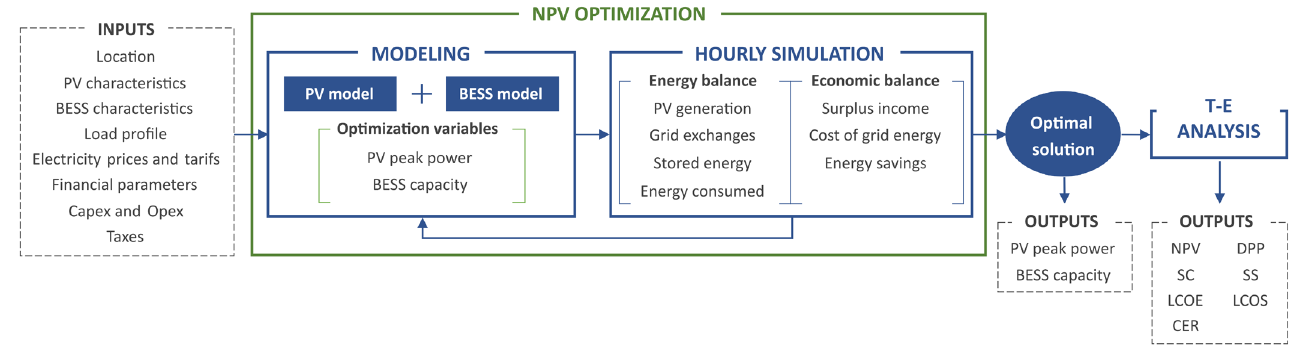
Figure 1. Optimization process implemented in the developed tool to design, simulate and assess PV systems comprising BESS.